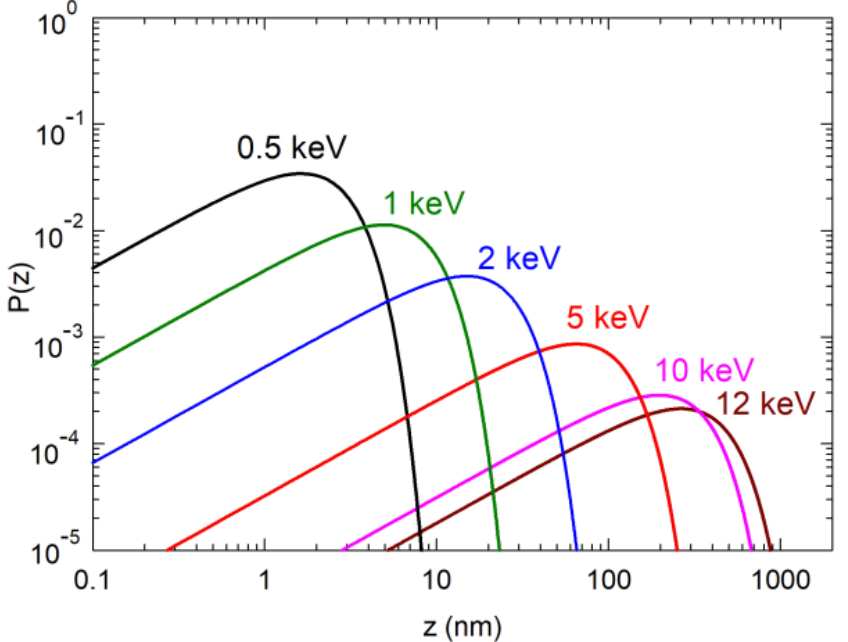
Figure 2. Implantation profiles of positrons with various energies into GaN. Labels indicate positron energy; z denotes the depth from the surface.